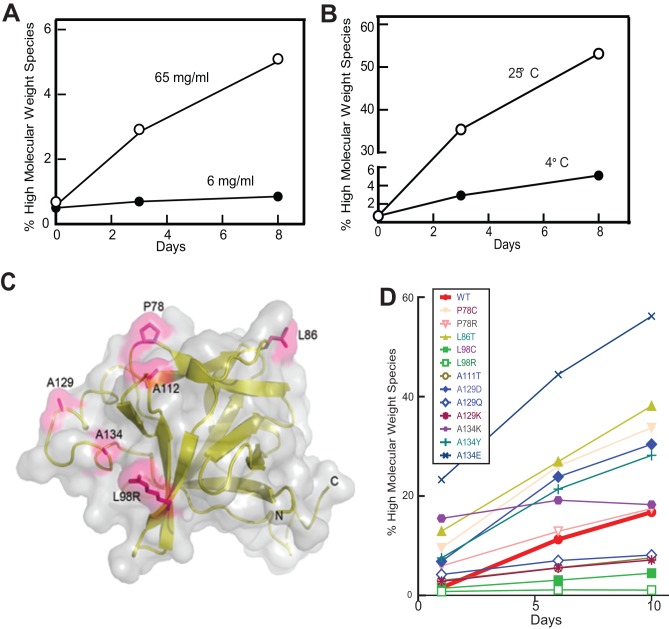
Identification of aggregation-resistant FGF21 mutants. (A–B) FGF21 aggregation was concentration-(A), temperature- (B), and time-dependent (A&B).The % of high molecular weight species over the total was obtained from size exclusion chromatography (SEC) analysis. (C) Homology model of FGF21 (residues 14–155) with the mutated residues shown in magenta. The leucine to arginine mutation is shown for residue 98 (magenta) and all other mutation sites were shown as native sequence. The FGF21 homology model was prepared using Modeler (Fiser and Sali) in Discovery studio 3.1 (Accelrys) with FGF19 (PDB code: 2P23) used as a template. Image was created using PyMol (Schrödinger, LLC). (D) The aggregation rate of FGF21 mutants. Samples were concentrated at 60±10 mg/ml and stored at 4°C for 1, 6 and 10 days before SEC analysis.